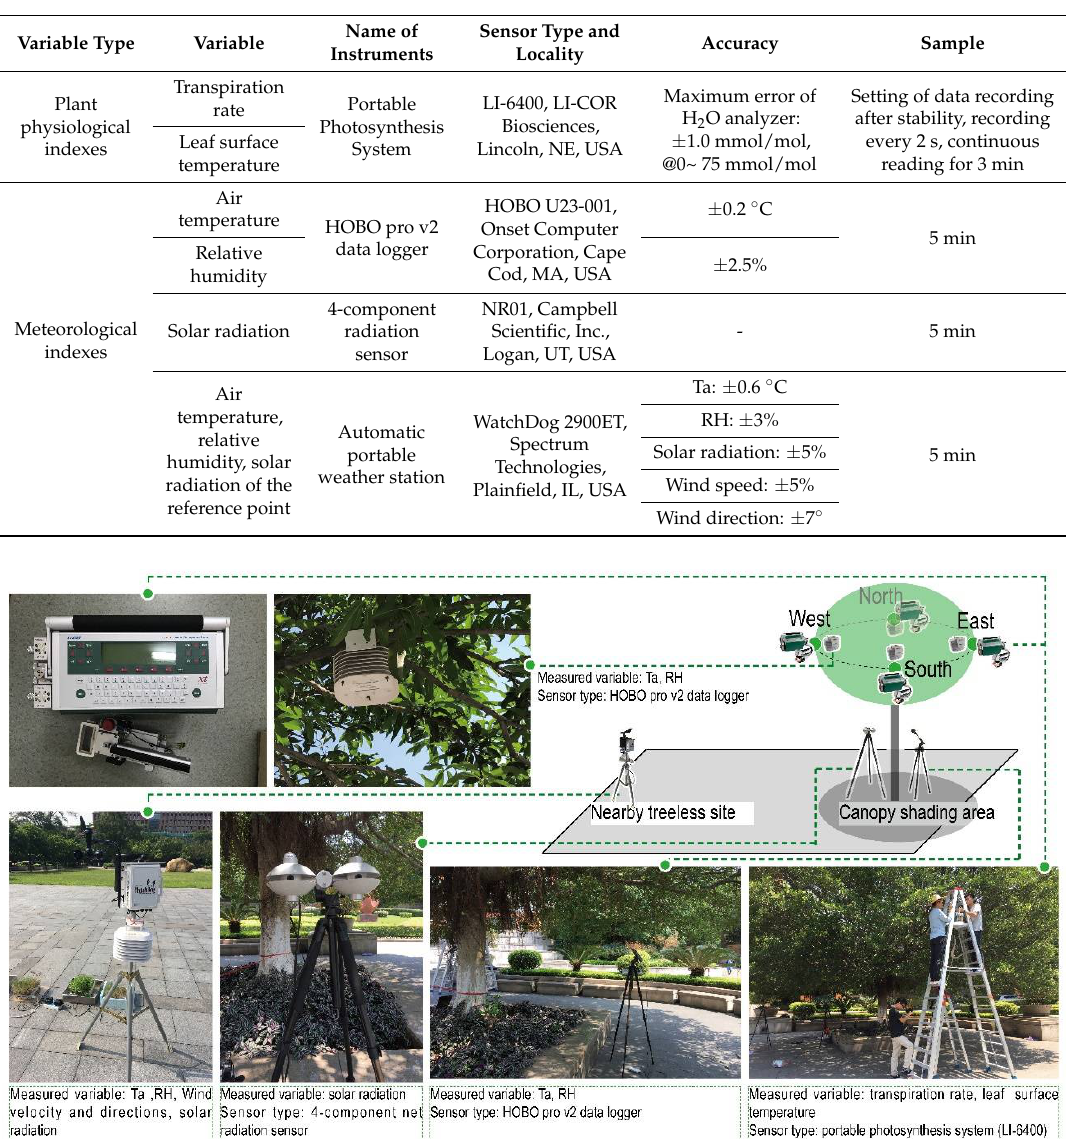
Table 2. Instrument types, locality, and accuracy.